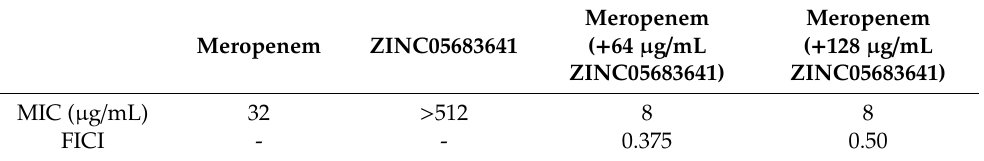
Table 2. MIC and FICI of meropenem in combination with ZINC05683641 against E. coli BL21 (pET28a-SP-NDM-1).